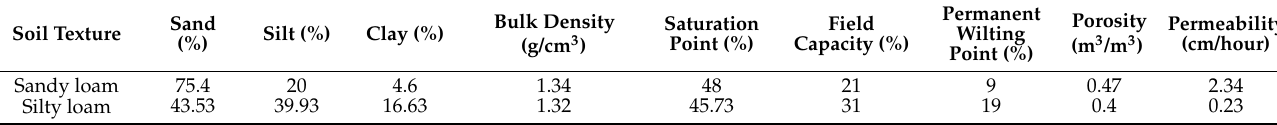
Table 2. Results of soil physical properties.